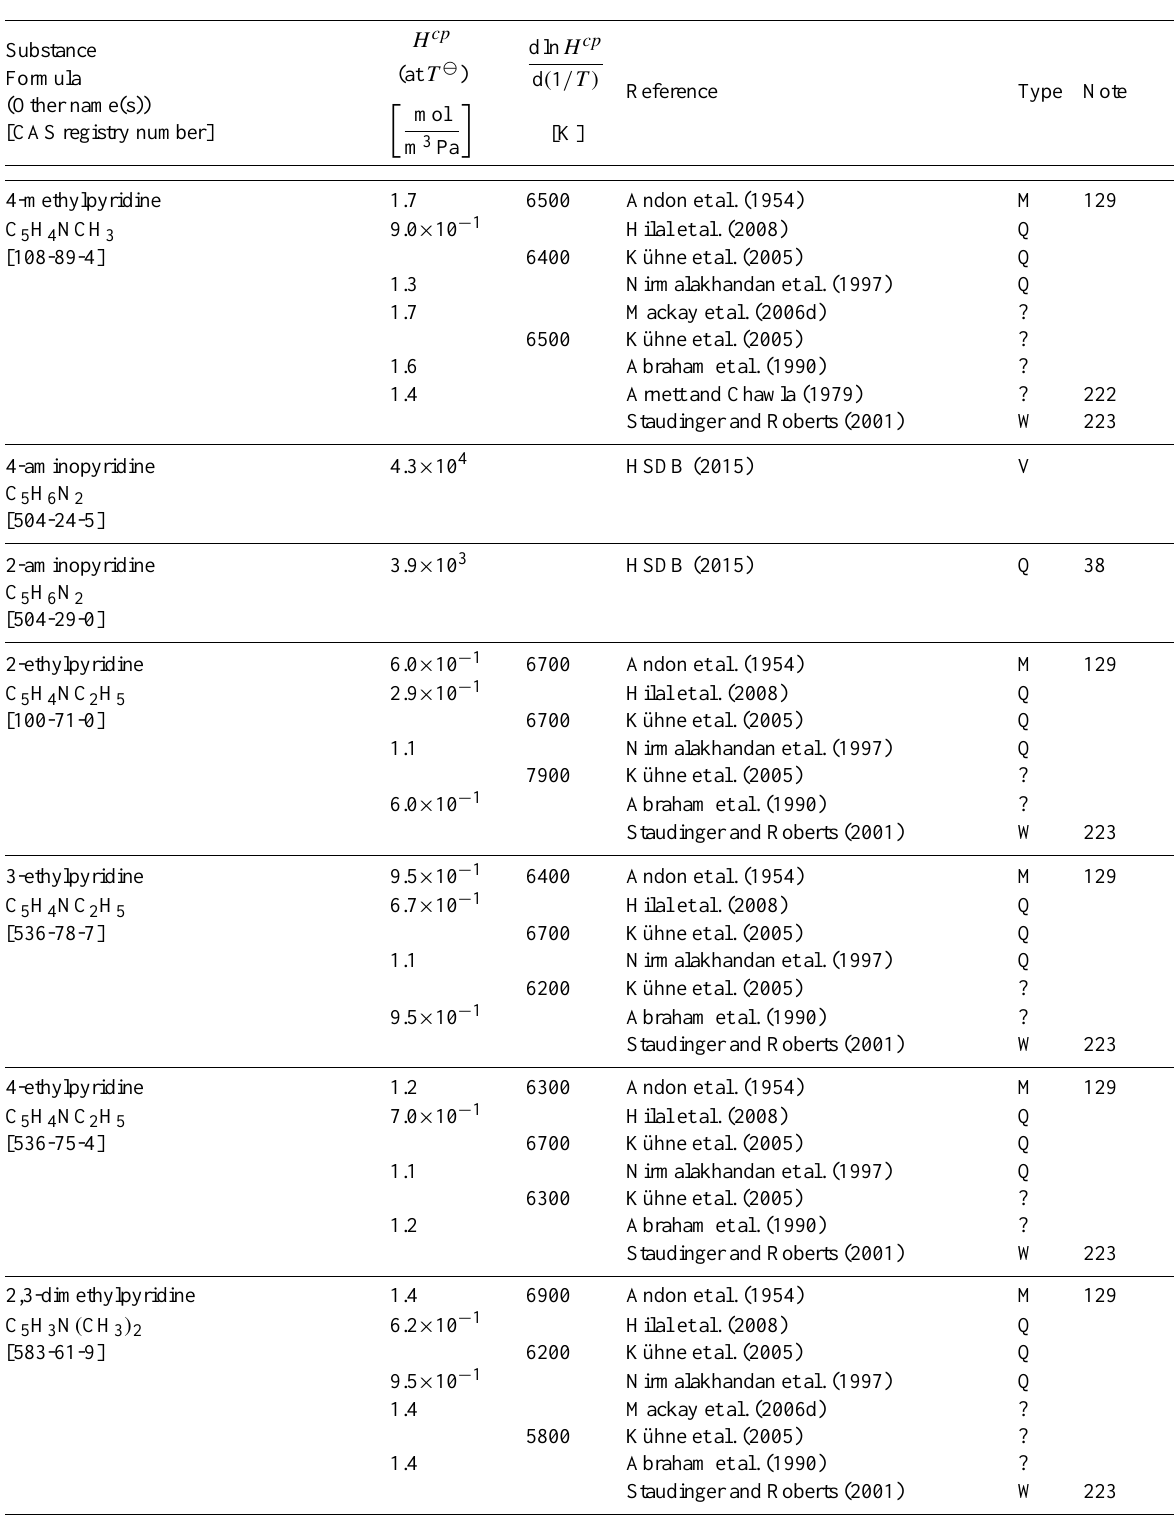
Table 6: Henry’s law constants for water as solvent